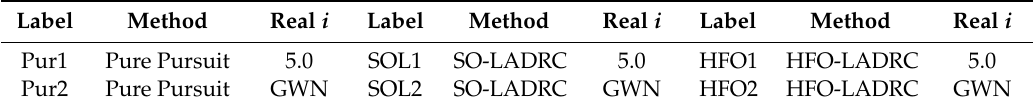
Figure 8. Steer ratio with Gaussian white noise (GWN). Table 4. Method and real steer ratio i